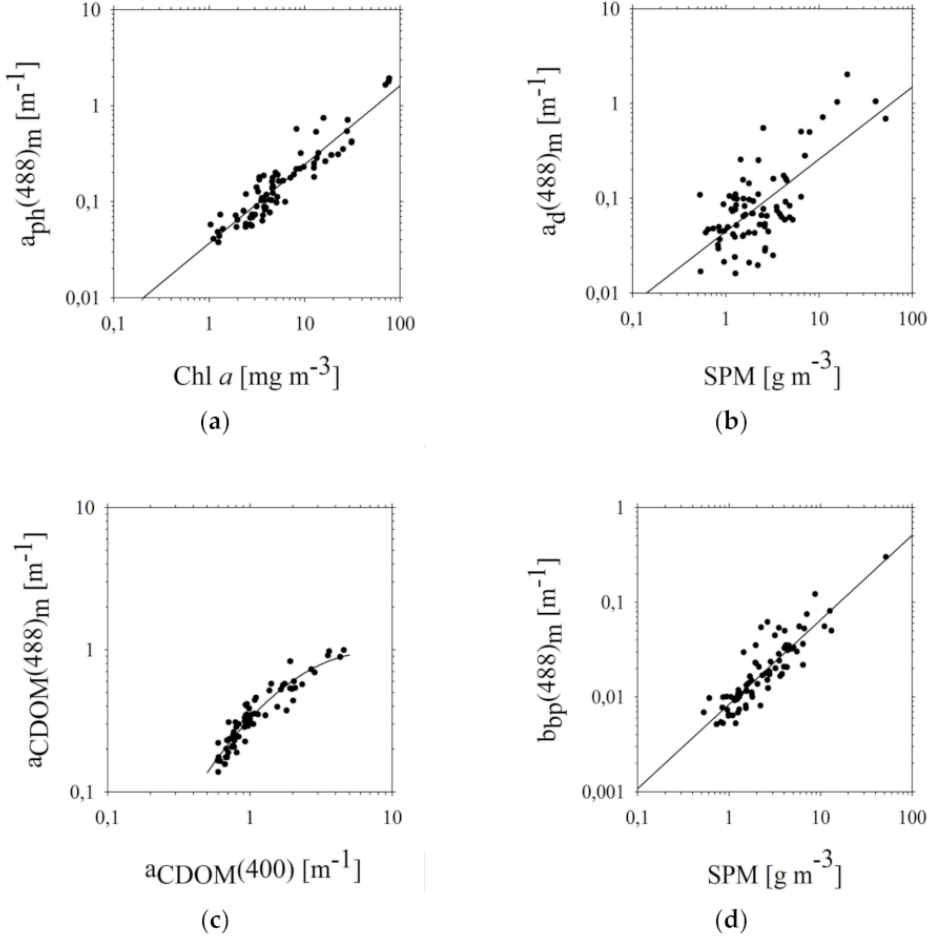
Figure 3. Relationships between ( a ) a ph and Chl a , ( b ) a d and SPM , ( c ) a CDOM and a CDOM (400), ( d ) b bp and SPM (for a wavelength of 488 nm) in the selected areas of the southern Baltic [line approximation by equations ( a ) 8, ( b ) 12, ( c ) 20, and ( d )